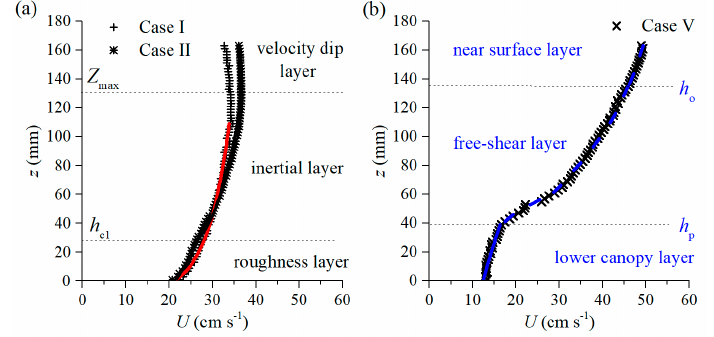
Figure 10. U Profiles along the depth for ( a ) Cases I & II and ( b ) Case V.